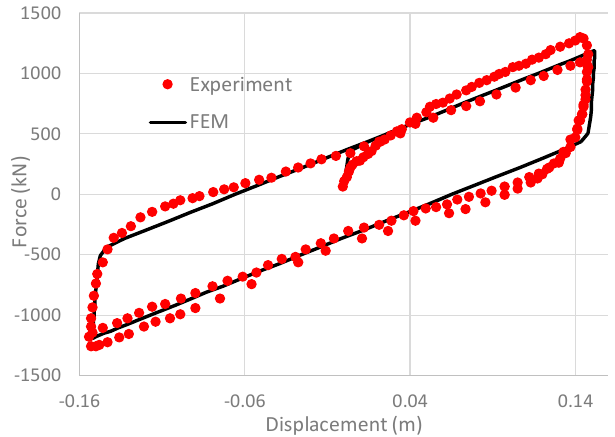
Figure 2. Experimental and finite element results for the LRB hysteresis curve.